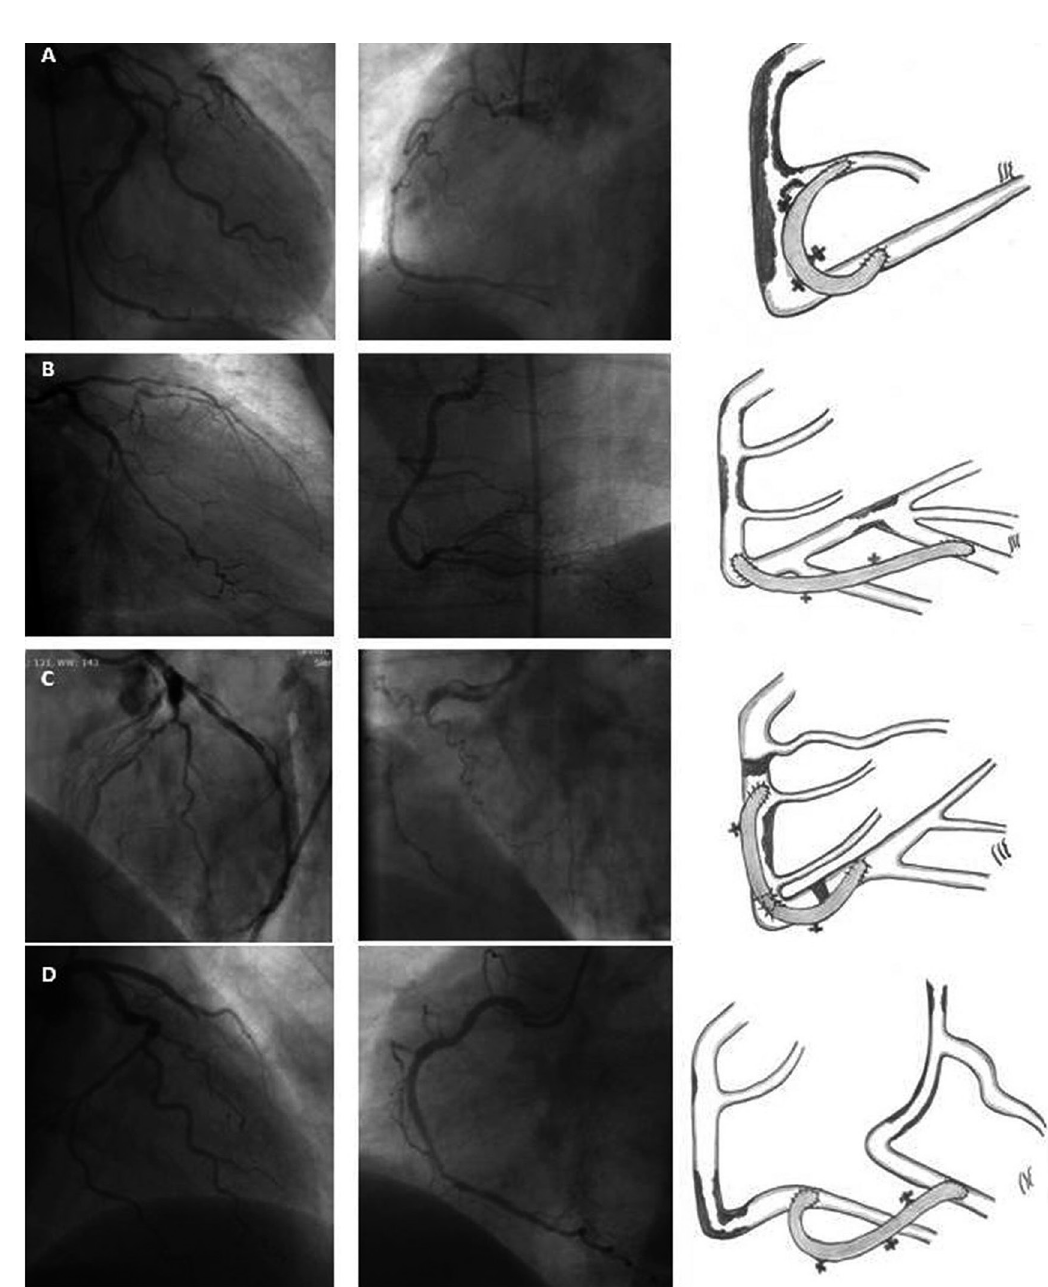
Fig. 1 - The examples of a right-sided intracoronary bridge. A-I: severe three vessel CAD with an occluded LAD. A-II: Diffuse MDR involving an anterolateral branch (the dashed arrow). A-III: ICB placed between the anterolateral branch and distal RCA. [ICB: radial artery; Inflow mode: IRTG with in situ RITA, see Fig. 2A]. B-I: Left coronary branches with diffuse LAD disease. B-II: a MDR. The dashed arrows show a second anterolateral and acute marginal branches arising from the RCA segment between the two stenoses. B-III: ICB placed between mid and distal RCA. [ICB: radial artery; Inflow mode: ITRG with in situ RITA]. C-I: LAD is nearly occluded; the distal segment of a dominant RCA is filled retrogradely (arrow). C-II: an occluded MDR, a second anterolateral and acute marginal branches are detected (dashed arrows). C-3: ICB providing 3 distal anastomoses. The distal anastomoses for second anterolateral and acute marginal branches are placed on the corresponding RCA segments. [ICB: radial artery; Inflow mode: IRTG with in situ RITA]. D-I: the arrow shows the left posterolateral branch; LAD is occluded. D-II: arrow shows an intrastent stenosis placed in mid RCA.D-III: ICB placed between PDA and left posterolateral branch [ICB: free-LITA; inflow mode: CRTG with free RITA; see Fig.